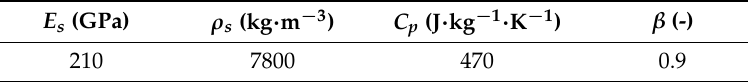
Table 1. Material properties of the investigated high strength